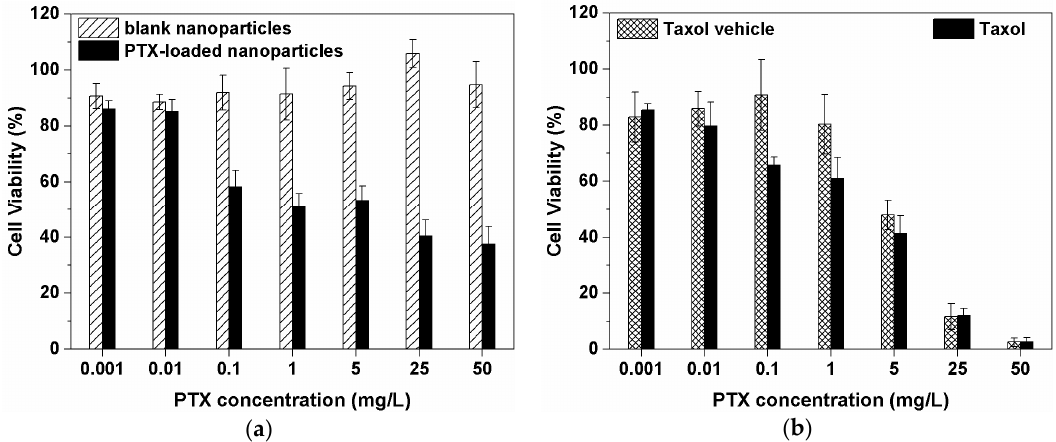
Figure 7. In vitro cytotoxicity of ( a ) mPEG-PAAHP-3 based PTX-loaded nanoparticles and blank nanoparticles, and ( b ) Taxol and Taxol vehicle on HeLa cells after 48 h of incubation. Data represent the mean and standard deviation of four independent experiments.